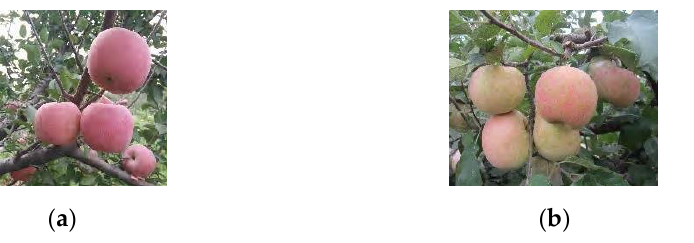
Figure 7. Two kinds of apple fruits: ( a ) completely red fruits; ( b ) incompletely red fruits (Photo: Reprinted with permission from Ref. [60]. 2019, Liu X.).